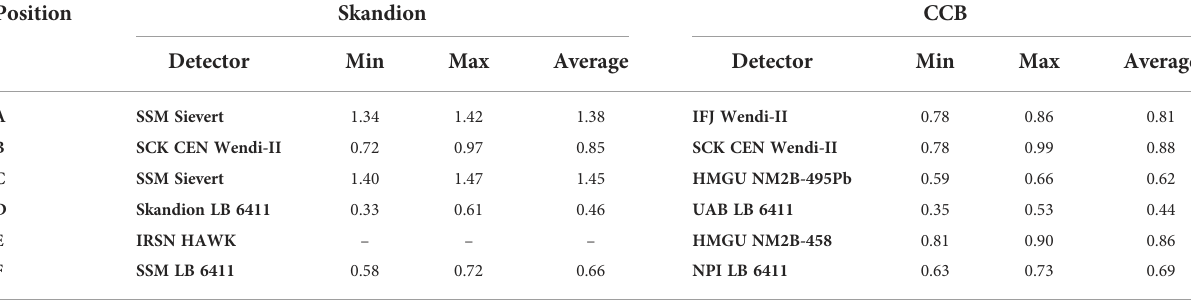
TABLE 3 Minimum, maximum, and average H*(10) responses of the different ambient neutron monitors at the different positions A-F as estimated from the convolution of the neutron H*(10) energy spectra simulated with the model without room speci fi cations and the simulated H*(10) energy